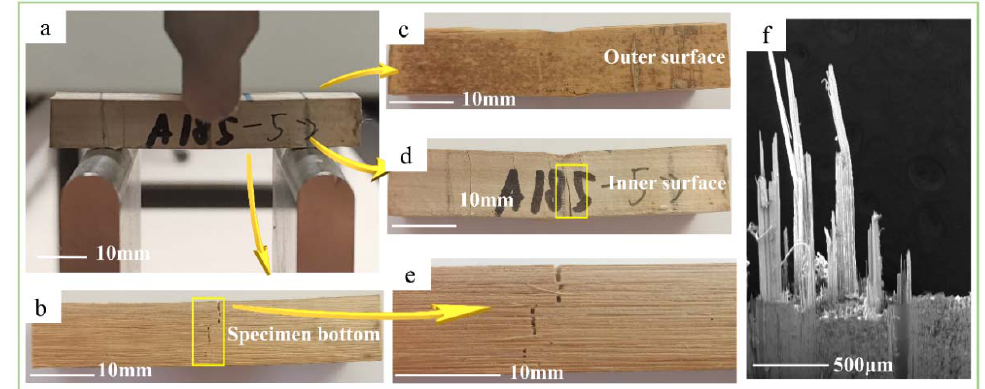
Figure 4. Shearing characteristics of tensile-shear method: ( a ) straight crack path at outer surface; ( b ) serrated crack path at inner surface; ( c ) shear-failure surface; ( d ) SEM image of smooth shear- failure surface.